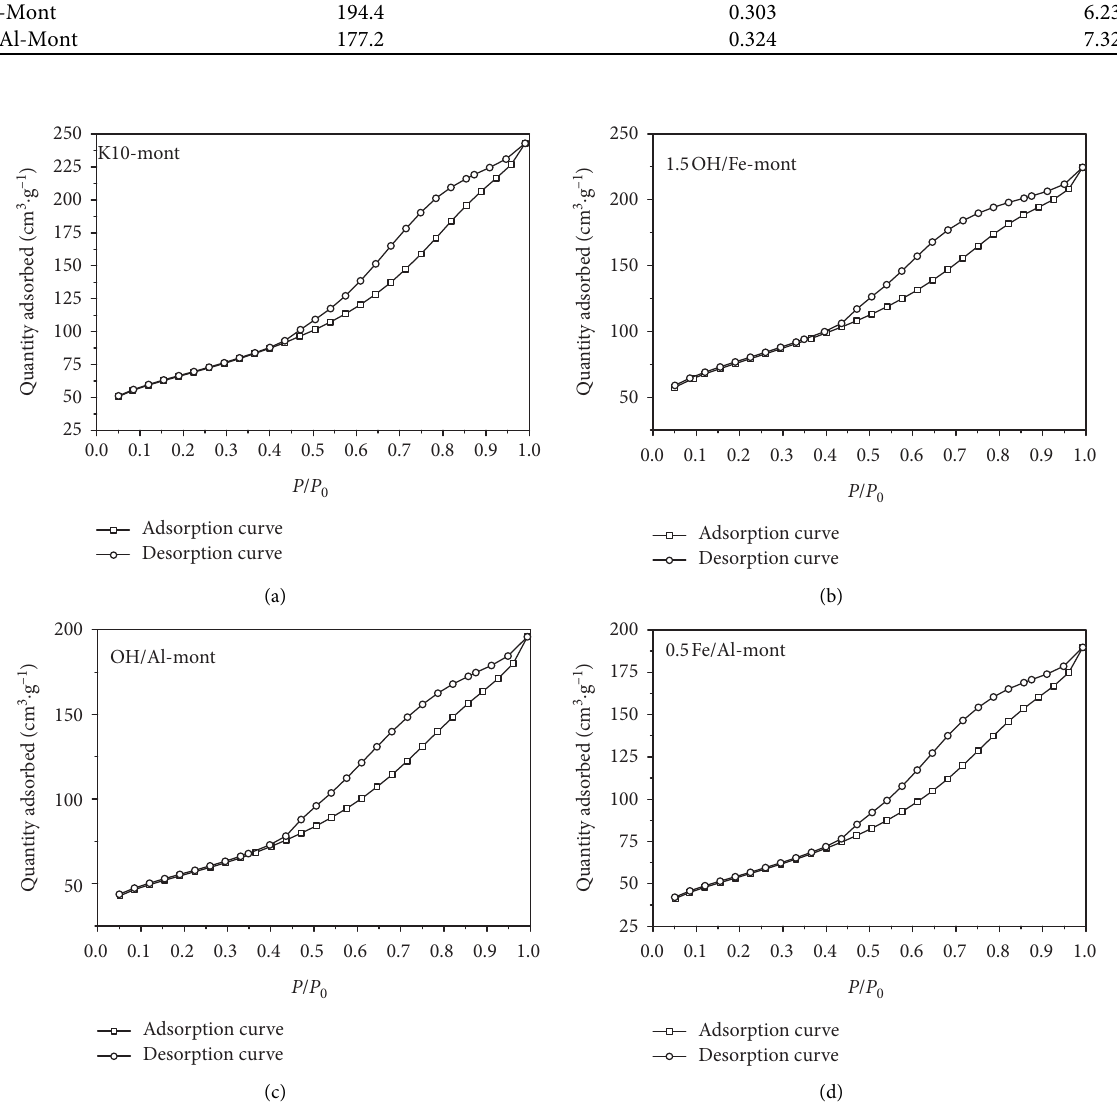
Figure 2: Nitrogen adsorption-desorption isotherm of hydroxyl-Fe-Al-pillared